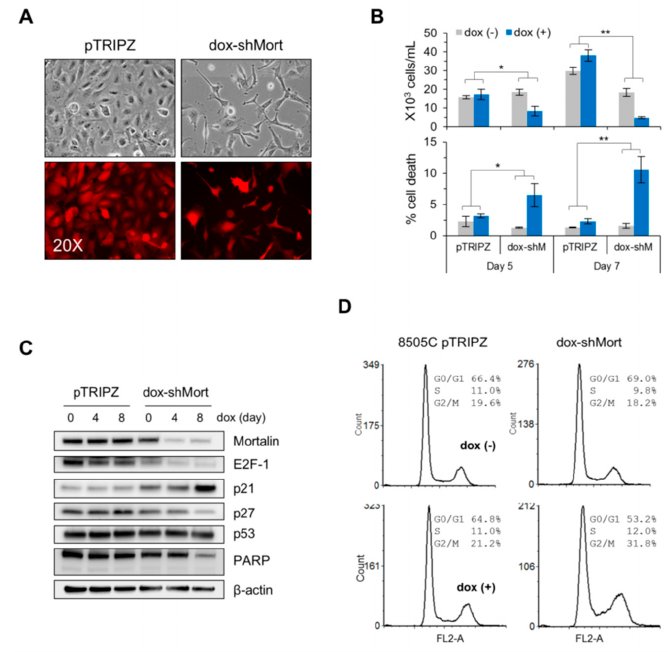
Figure 4. Mortalin knockdown induces growth inhibition in the ATC cell line, 8505C. ( A – D ) 8505C cells were infected with the lentiviral pTRIPZ-dox-shMort or the empty pTRIPZ. ( A ) Dox-induced RFP expression indicates infection efficacy. ( B ) Trypan blue exclusion analysis of live and dead cells at dox treatment day 5 and 7 (mean ± SD, n = 3), * p < 0.05; ** p < 0.005. ( C ) Western blot analyses of total cell lysates harvested at indicated dox treatment days. β -actin is the control for equal amounts of protein loading. ( D ) Cell cycle analysis after 8 day dox treatment. Int. J. Mol. Sci. 2018 , 19 , x FOR PEER REVIEW